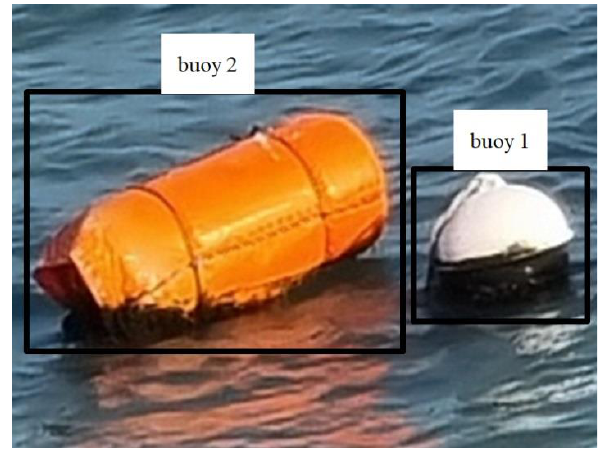
Figure 8. Learning data. Table 2. The information of